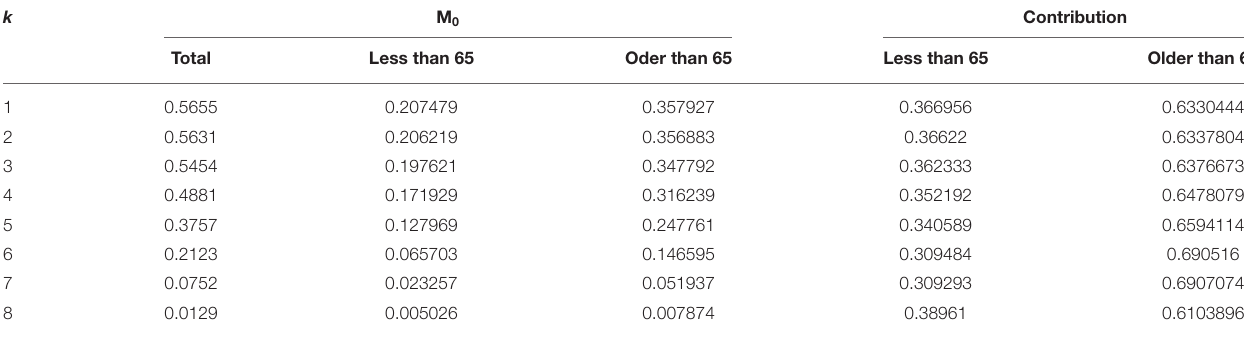
TABLE 5 | Multidimensional disability index (M 0 ) and contribution rate under different k values were broken down by age.